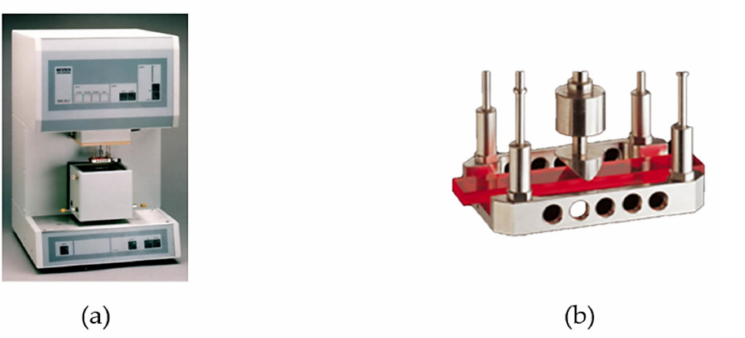
Figure 1. ( a ) Dynamic Mechanical Analyser DMA 242C device by Netzsch Selb, Germany, and ( b ) view of sample holder for 3 point bending